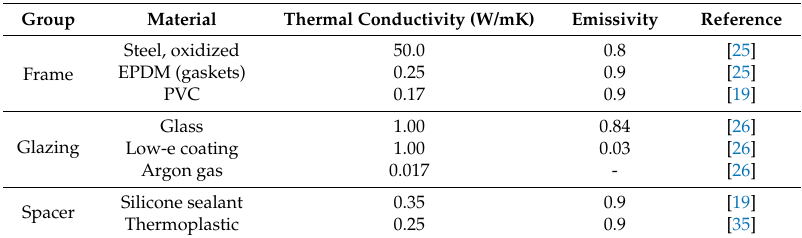
Table 3. Material properties for the numerical simulation.